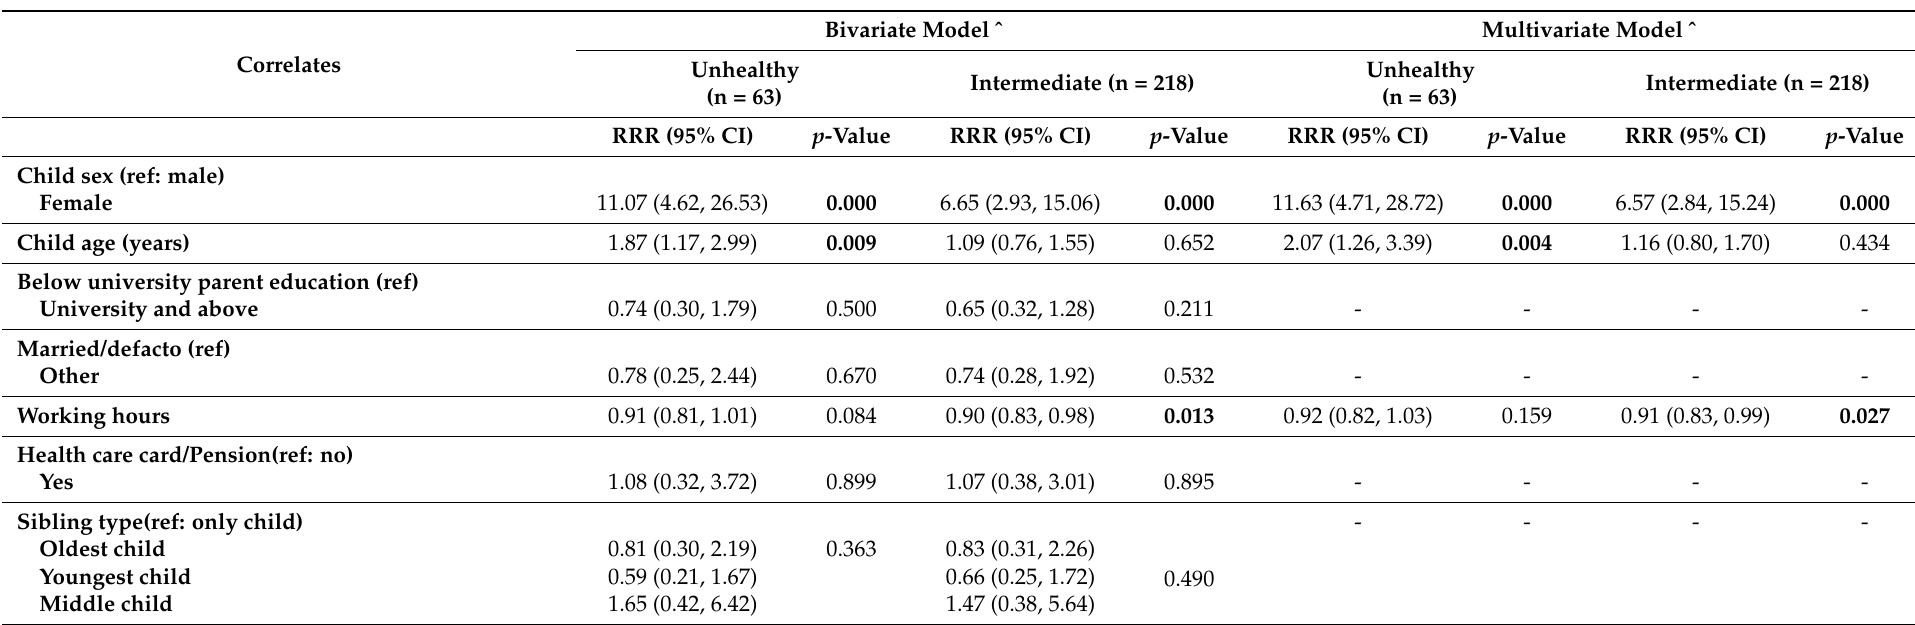
Table 3. Associations of behavioural patterns and child and family level correlates at 9–11 y (n =